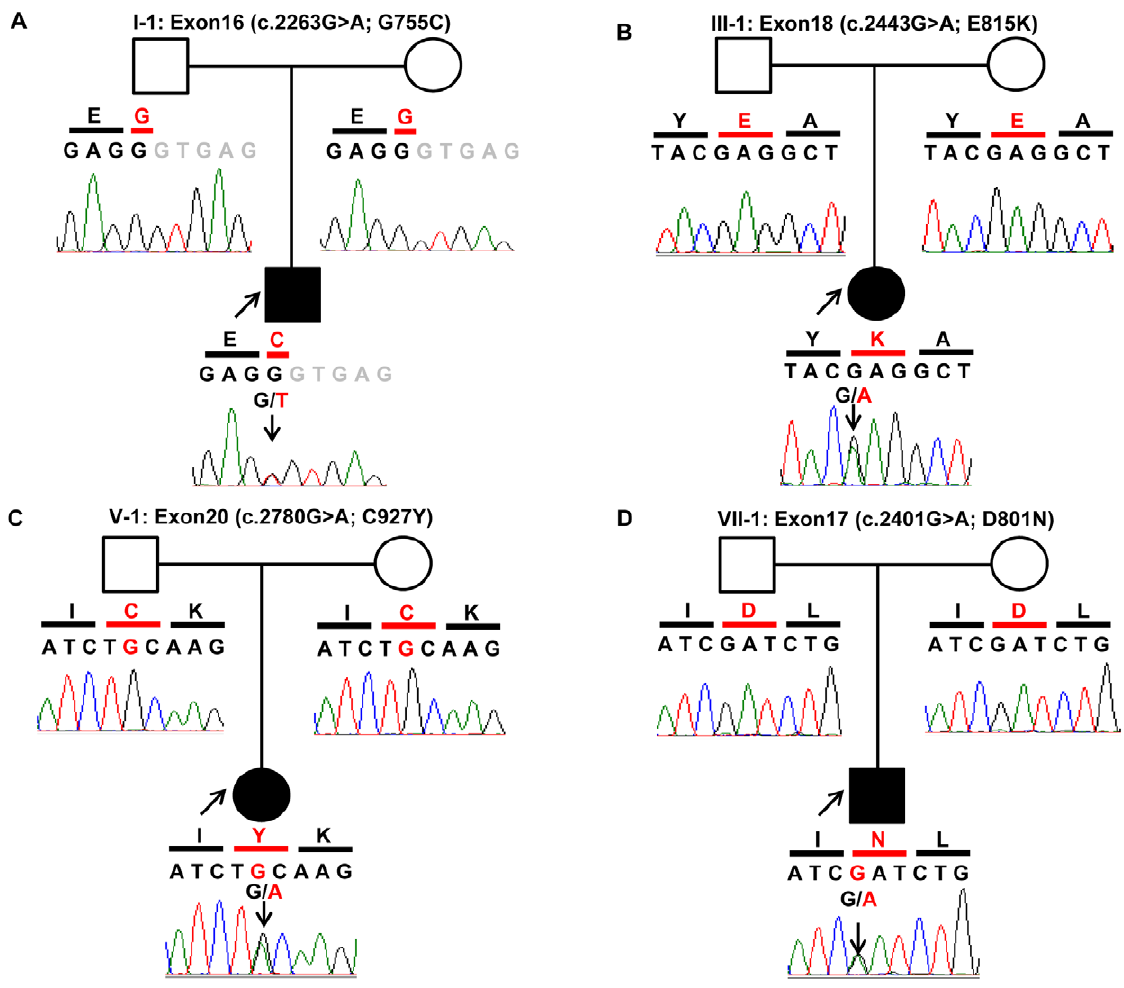
Figure 2. Chromatograms of four de novo mutations identified in ATP1A3 . Data were obtained by Sanger sequencing during the confirmation process. In trio of each pedigree, black shadow represents the proband. In the chromatograms, Black letters show exonic nucleotide sequences, gray letters show intronic nucleotide sequences. Amino acids are shown in a single letter notation. Nucleotides and amino acids in red indicate mutations. (A) G755C was identified only in Patient I-1. (B) E815K was identified in Patients II-1, III-1, IV-1, IX-1 and X-1. (C) C927Y was identified in Patient V-1 only. (D) D801N was identified in Patients VI-1, VII-1 and VIII-1. None of the mutations was detected in the father or mother except for Patient IX-1, whose parents refused to undergo genetic